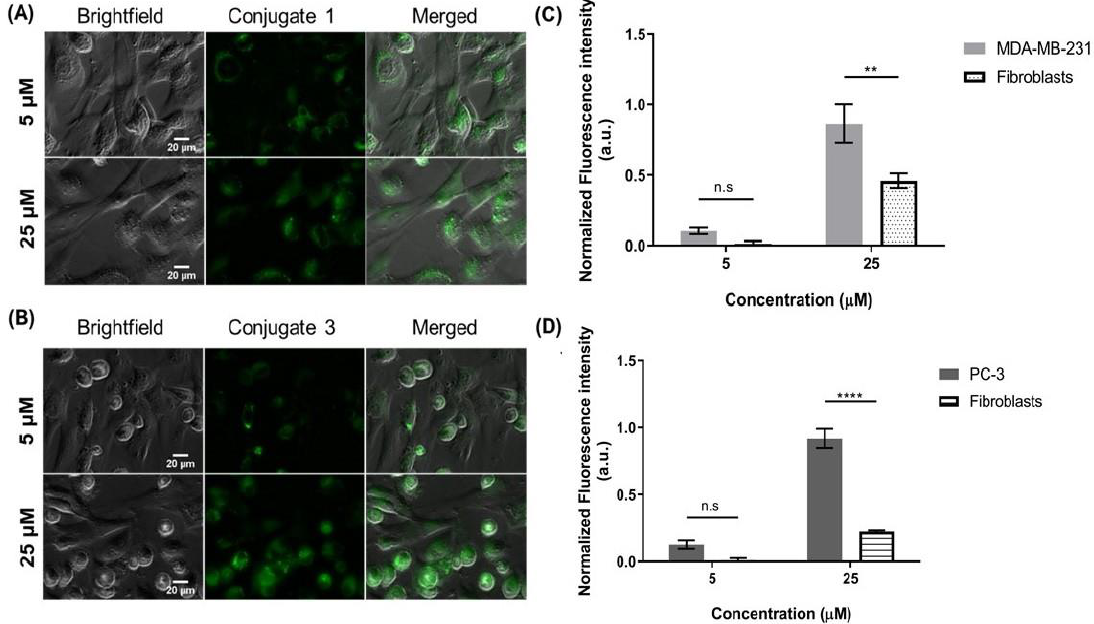
Figure 3. Internalization of E2-BODIPY conjugate 1 and 19-nortestosterone-BODIPY conjugate 3 in MDA-MB-231/fibroblast or PC-3/fibroblast co-cultures. Co-cultures were incubated for 6 h with 0.25% ( v / v ) DMSO (control) or 5 μM and 25 μM of steroid-BODIPY conjugate (conjugate 1 for MDA-MB-231: fibroblast co-culture and conjugate 3 for PC-3: fibroblast co-culture). ( A ) MDA-MB-231: fibroblasts and ( C ) PC-3. The fibroblast cells were visualized by an inverted microscope, and the fluorescence intensity was quantified for each co-culture, ( B , D ), respectively. The fluorescence intensity of the cells was corrected for background fluorescence and normalized with vehicle (DMSO). The statistical significance was evaluated by the two-way ANOVA method (** p ≤ 0.01, **** p ≤ 0.0001, n.s — not significant).